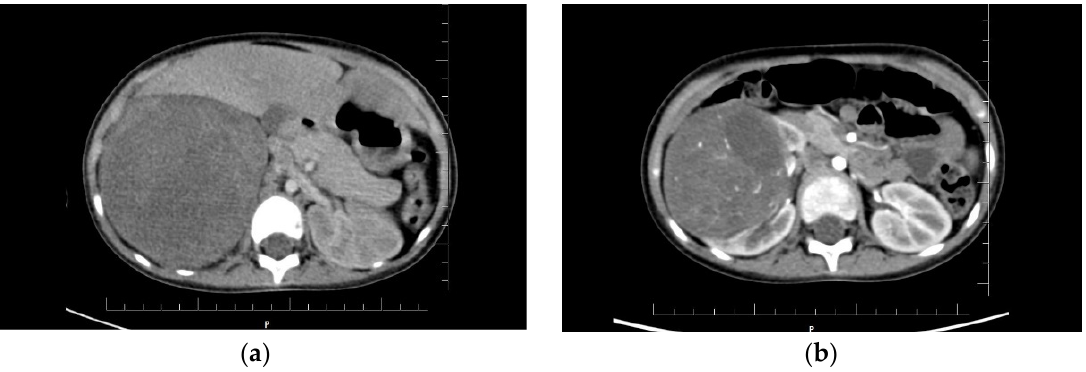
Figure 1. The results of the computed tomography examination in both patients: ( a ) Visible tumor of the right kidney in the first girl, size 10 × 9.3 × 12.6 cm; ( b ) Visible tumor of the right kidney in the second child, size 7 × 6.1 × 7.7 cm.